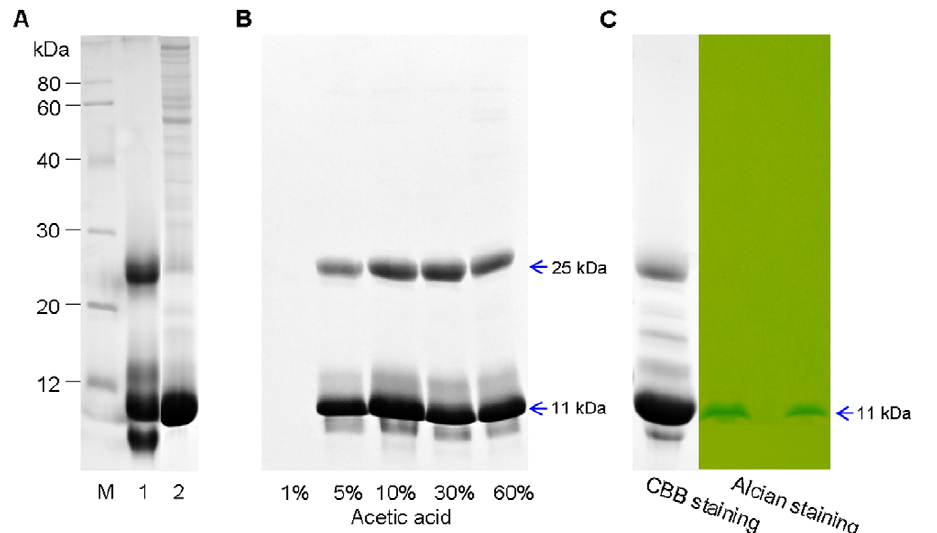
Figure 3. Sequential protein extraction improved the SDS-PAGE profiles of P.ternata tuber proteins. A , equal amounts of proteins (25 m g) from each extract were separated by SDS-PAGE. B , depletion effect of different concentrations of acetic acid. C , detection of glycoproteins in P. ternata tubers. Total tuber proteins were resolved by SDS-PAGE and visualized by CBB (protein load 25 m g) and Alcian stain (protein load 10 m g), respectively. Only the 11 kDa band was stained by Alcian staining, indicating a glycoprotein.